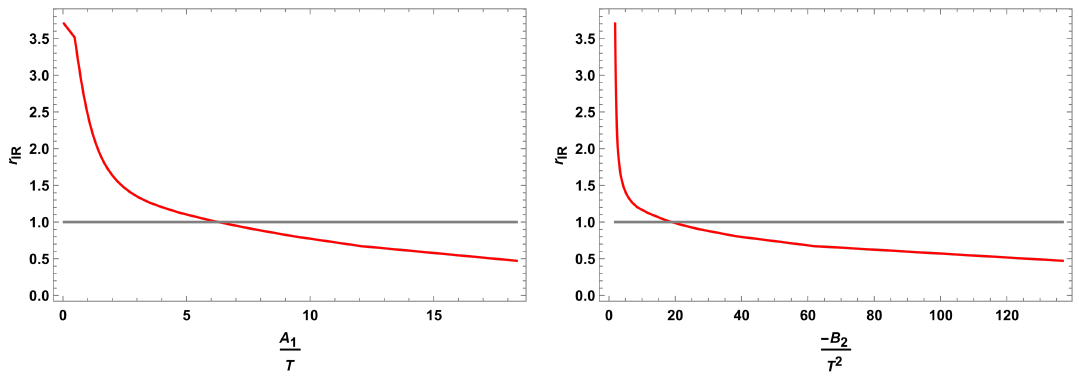
) vs r for the SUGRA model. We have chosen three p , − B 2 ), shown on the right). The vertical T T 2 . 32